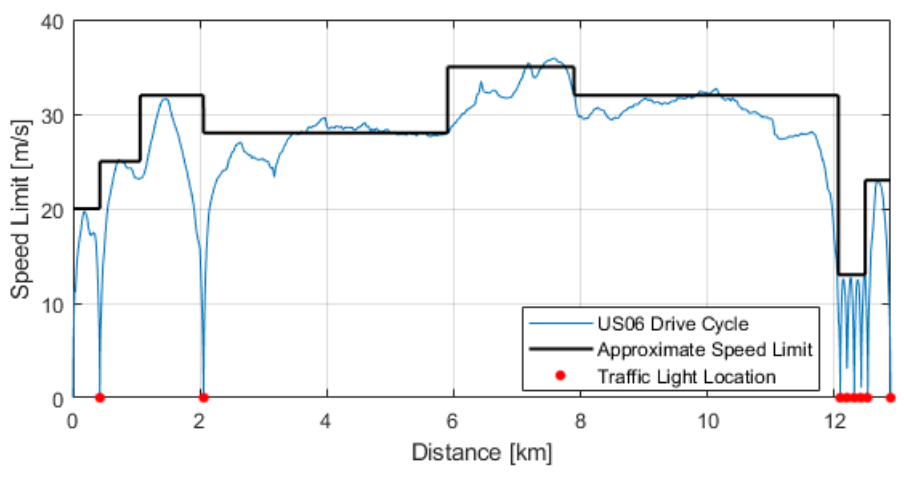
Figure 4. Speed limit based on